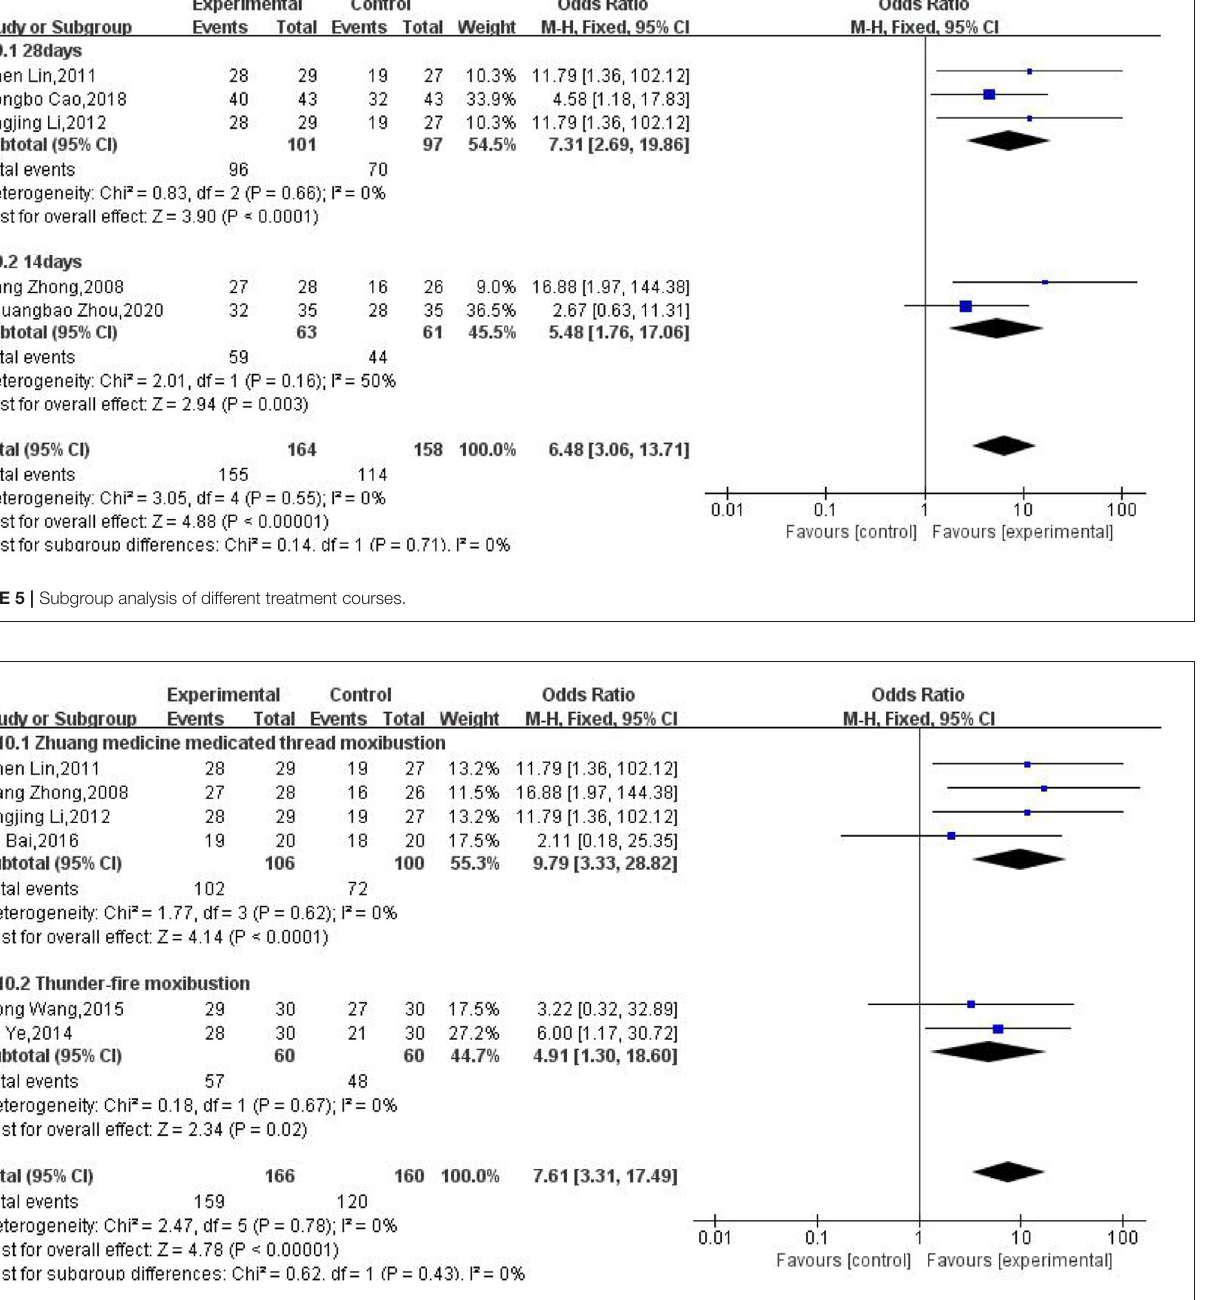
FIGURE 6 | Subgroup analysis of the different modalities used for moxibustion